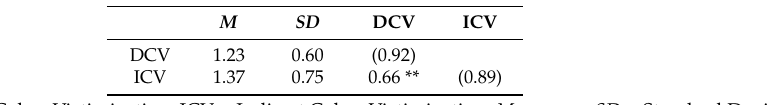
Table 3. Descriptive statistics, factor correlations, and Cronbach’s alpha (in parentheses) for the 2-factor model.